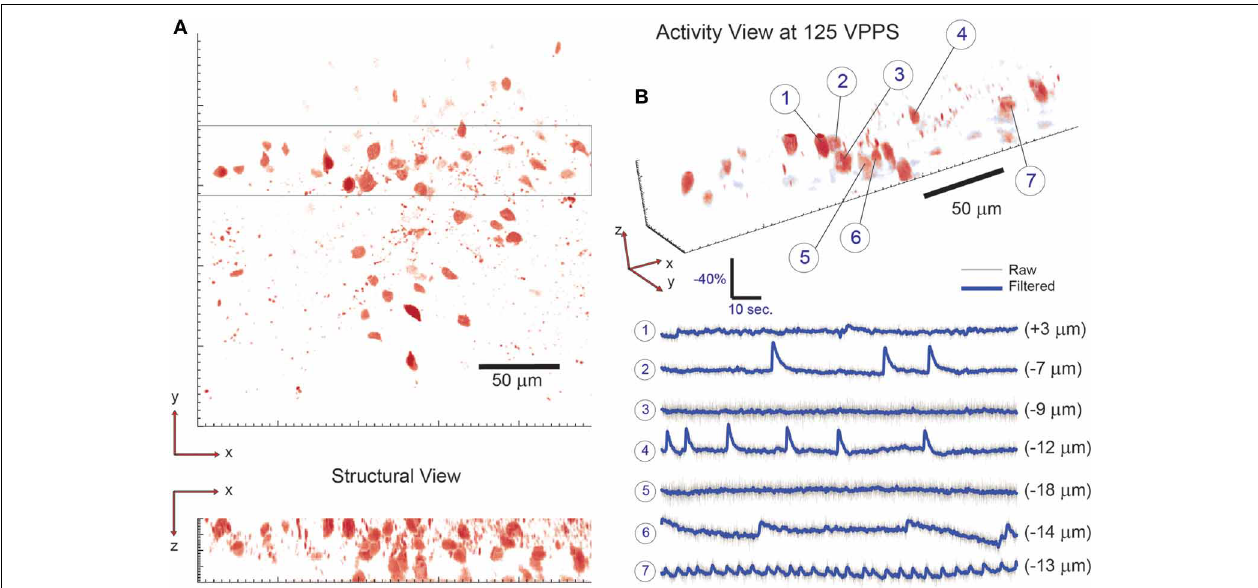
FIGURE 5 | 3D imaging of neuronal activity in dentate gyrus with single-cell resolution at 125 volume projections per second. (A) The location of neuronal cells within the volume of interest is determined by collecting a two-photon raster-scanning image stack and identifying cell bodies. To demonstrate 3D sensing capability with single-cell resolution, 7 neighboring cells are selected from the 3D sub-volume highlighted in